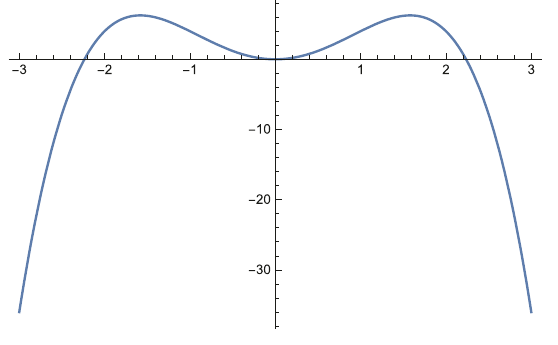
Figure 10 . Inverted double-well potential of V = 5 x 2 − x 4